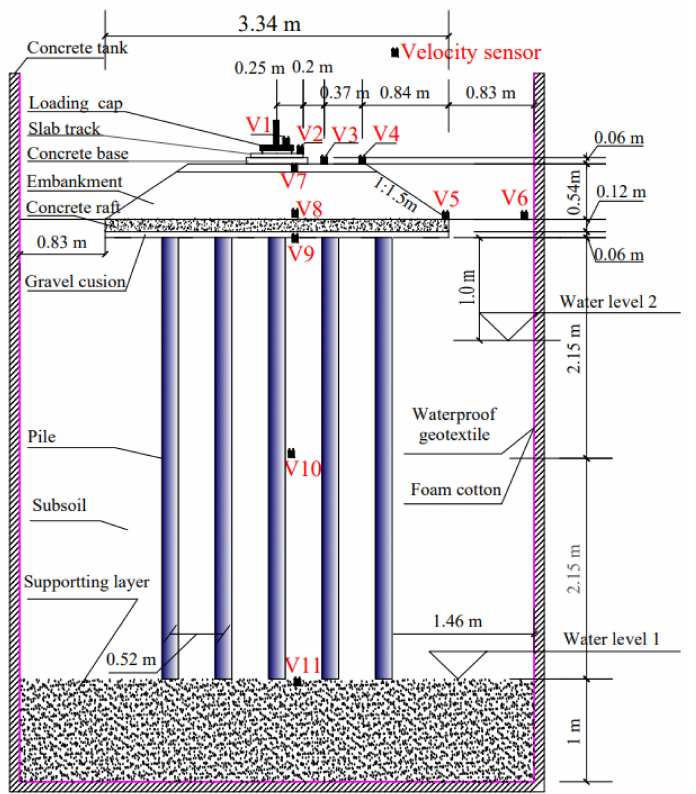
Figure 2. Layout of experimental model.